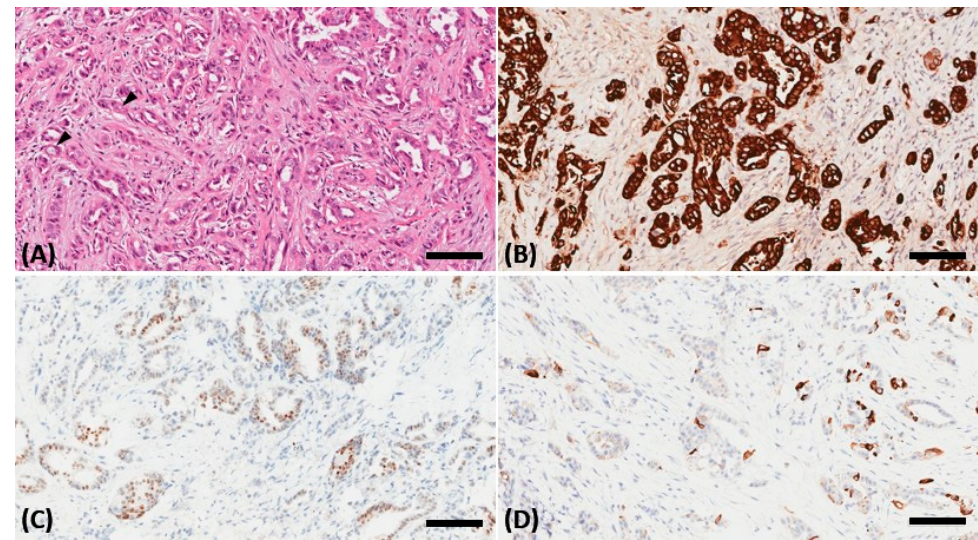
Figure 3. A biopsy of the orbital mass revealing an intestinal-type adenocarcinoma in the hematoxylin and eosin stain characterized by a glandular tumor growth pattern with scattered goblet cell differentiation (black arrowhead) and hyperchromatic nuclei ( A ). On immunohistochemical staining, the tumor cells showed positive staining for cytokeratin (CK)7 ( B ), scatter staining for CK20 ( C ), and focal nuclear staining for CDX2 ( D ). The scale bar is 100 μ m.